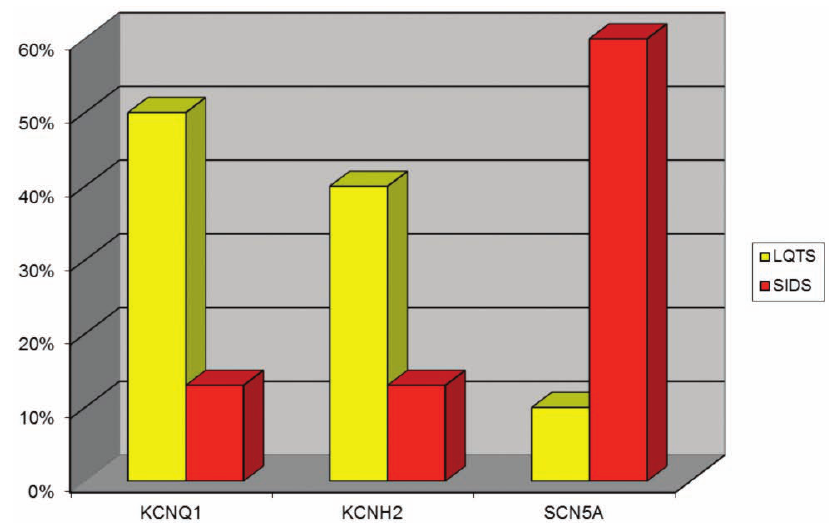
Figure 2. Distribution of mutation carriers in the 3 main LQTS genes, respectively for LQTS adult patients (in yellow) and SIDS cases (in red). The percentage of LQTS cases with a single mutation is calculated according to Kapplinger et al. ; 52 the percentage of mutations carriers in SIDS is calculated according to Table